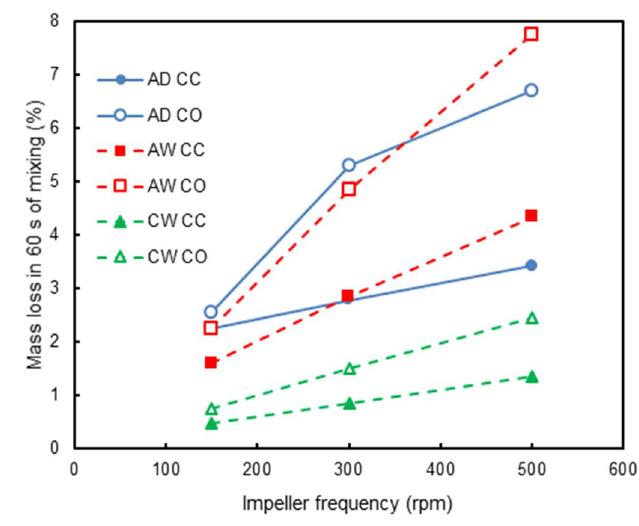
Figure 11. Simulations on the effect of impeller frequency on the predicted mass loss for tests with coarse aggregates only (AD, dry mixing, and AW, wet mixing), co- and counter-current configurations and 60 s of mixing, as well as for the wet concrete mixture (CW). Dry mixing was modelled by means of a non-slip Hertz–Mindlin contact law, while wet mixing is simulated by a cohesive contact model (Hertz–Mindlin with JKR). Mass loss is predicted using Equations (5) and (6).